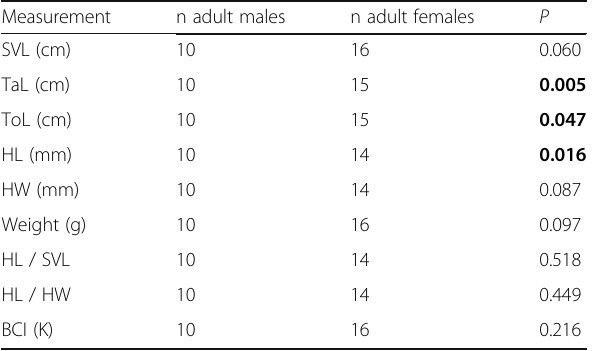
Table 4 Results of the t test for comparison of normally distributed morphometric characteristics of blunt-nosed vipers from Cyprus (significant P values bold)